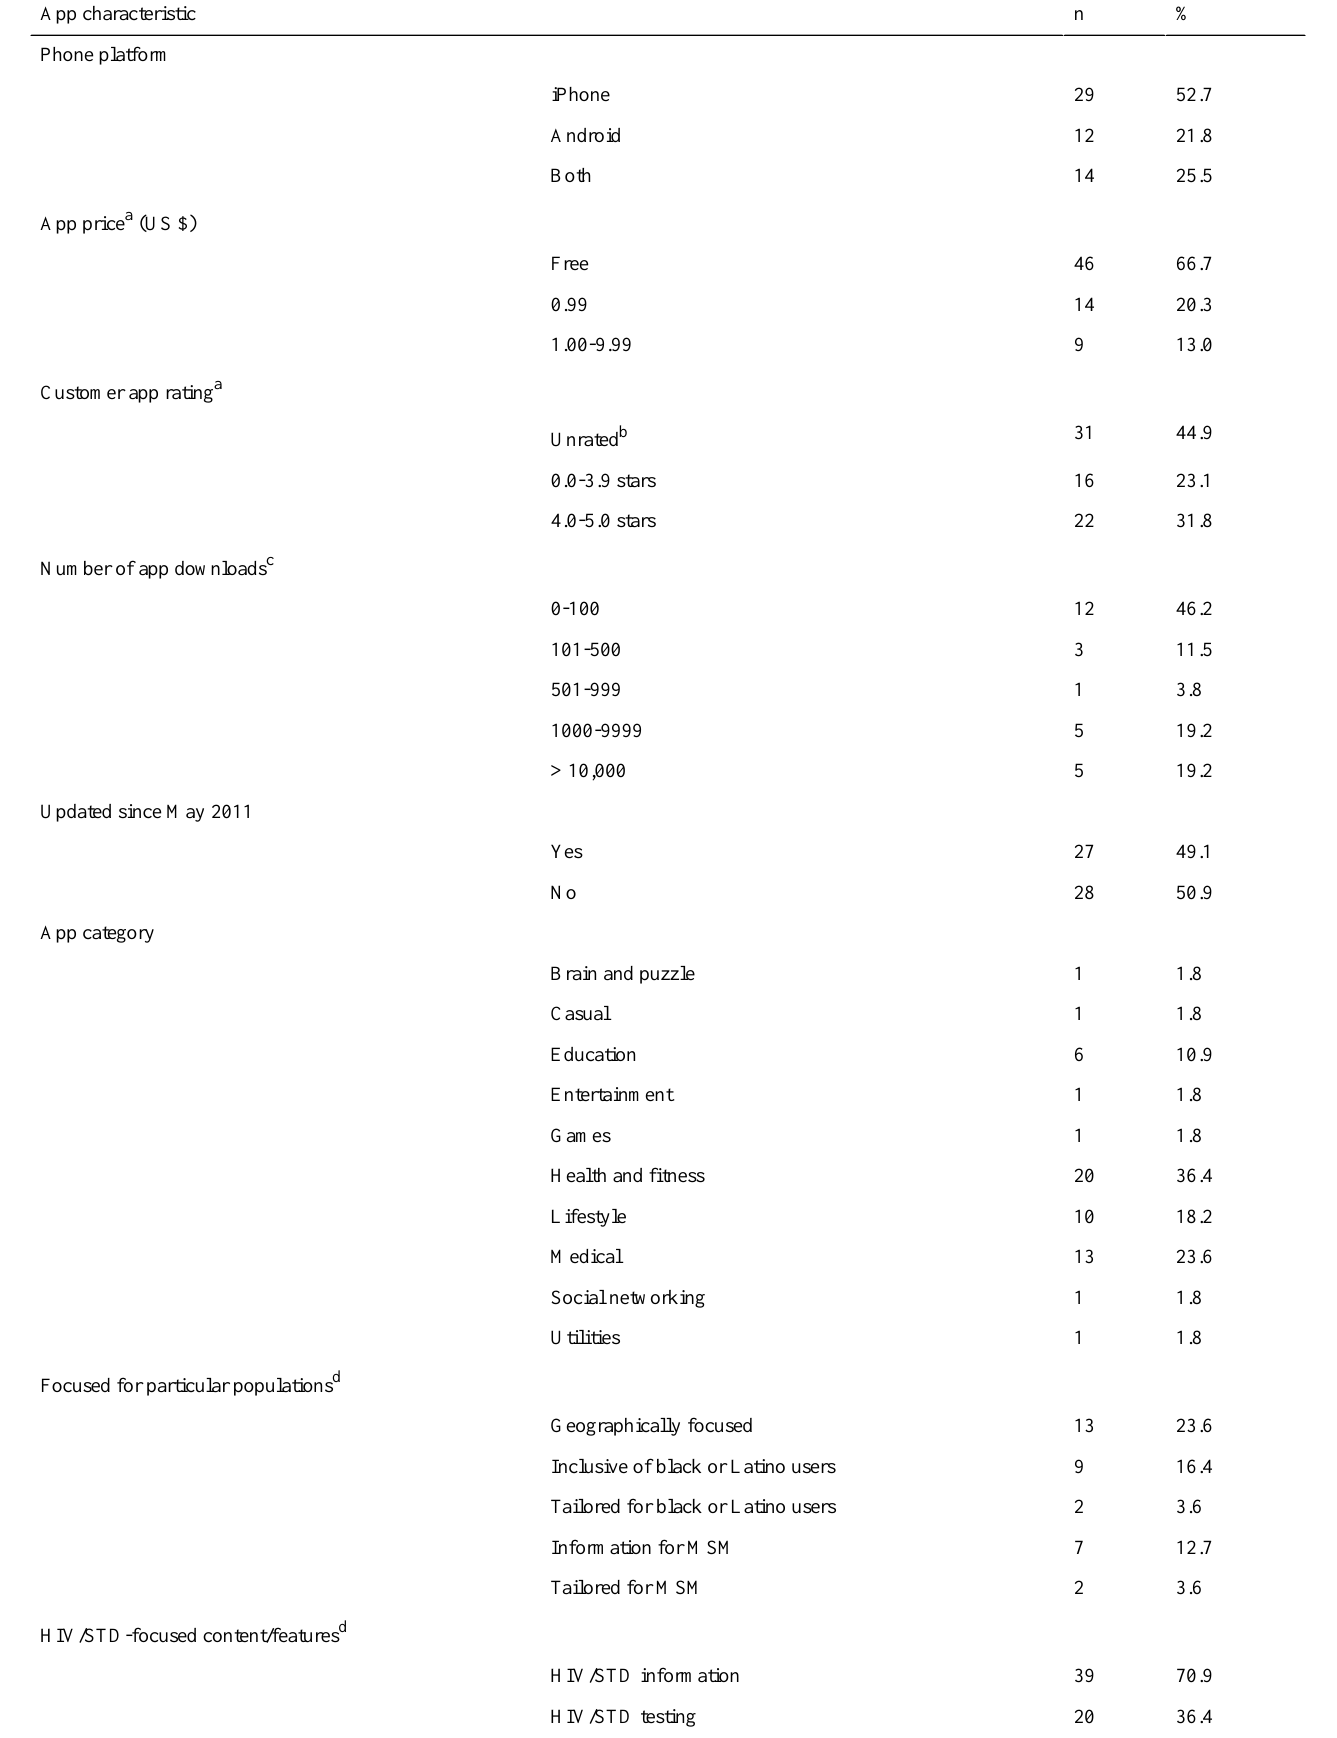
Table 1. Summary of mobile phone applications (apps) for HIV/STD prevention and care